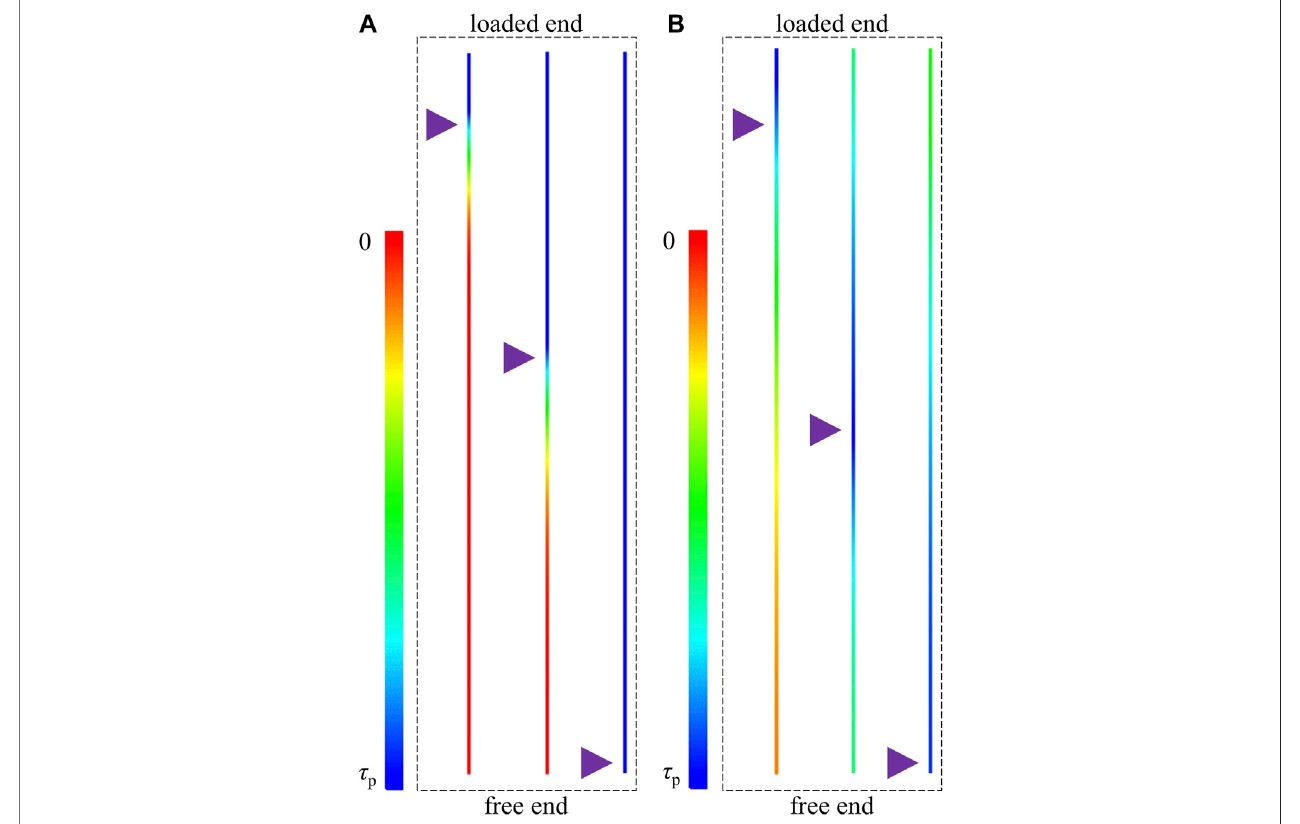
FIGURE 1 | Comparison between the structure element of pile in analyzing the SS propagation process: (A) The original pile and (B) the revised pile.